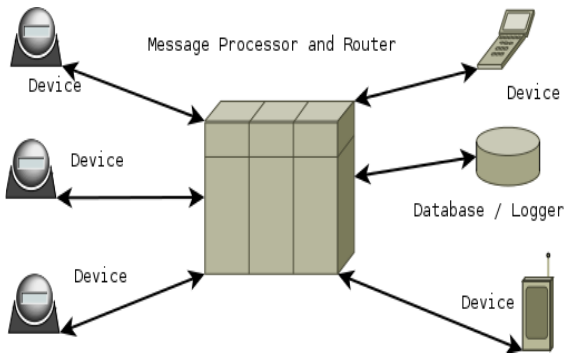
Figure 1. Multiple Message Sources and Shared Data Talking to One Message